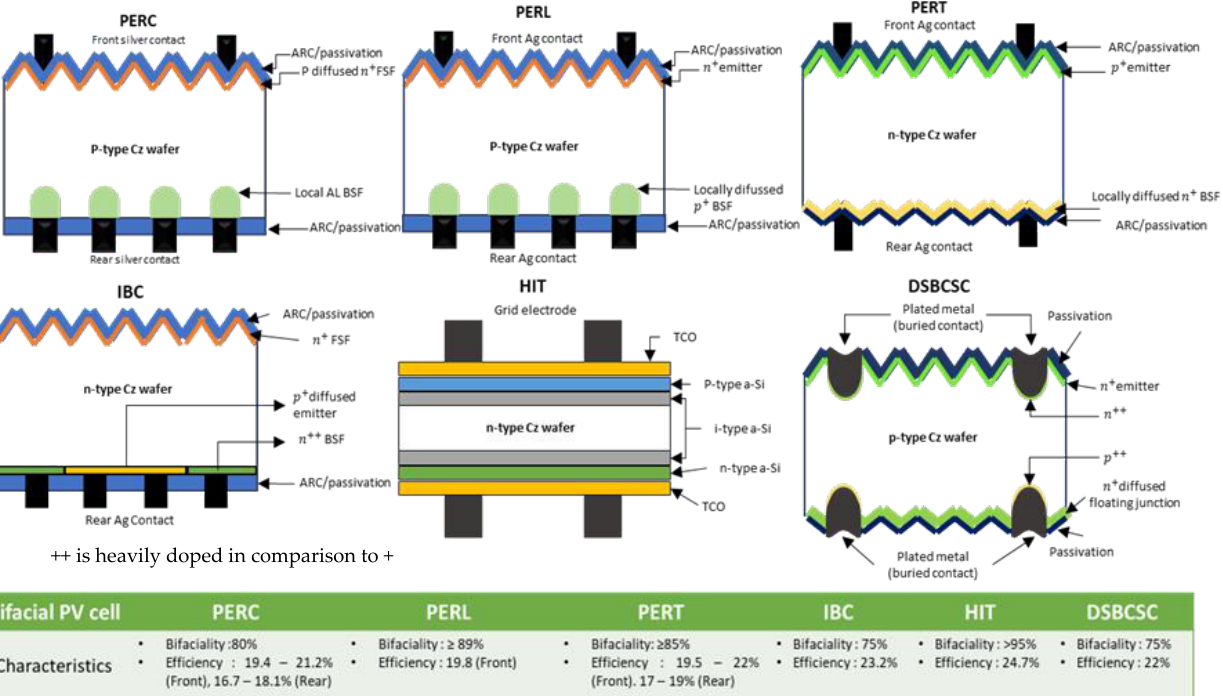
Figure 3. Non-exhaustive list of bifacial photovoltaic cell technologies adapted from [5].